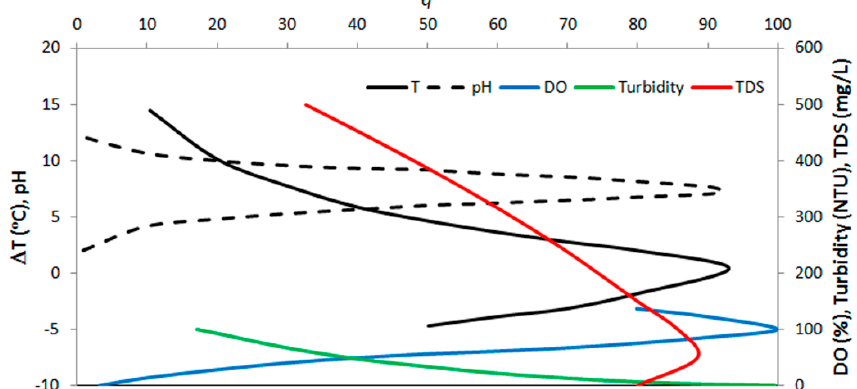
Figure 4. Standardization curves used to transform the water quality parameters into q scores (Equation (1)). Source: https://cetesb.sp.gov.br.